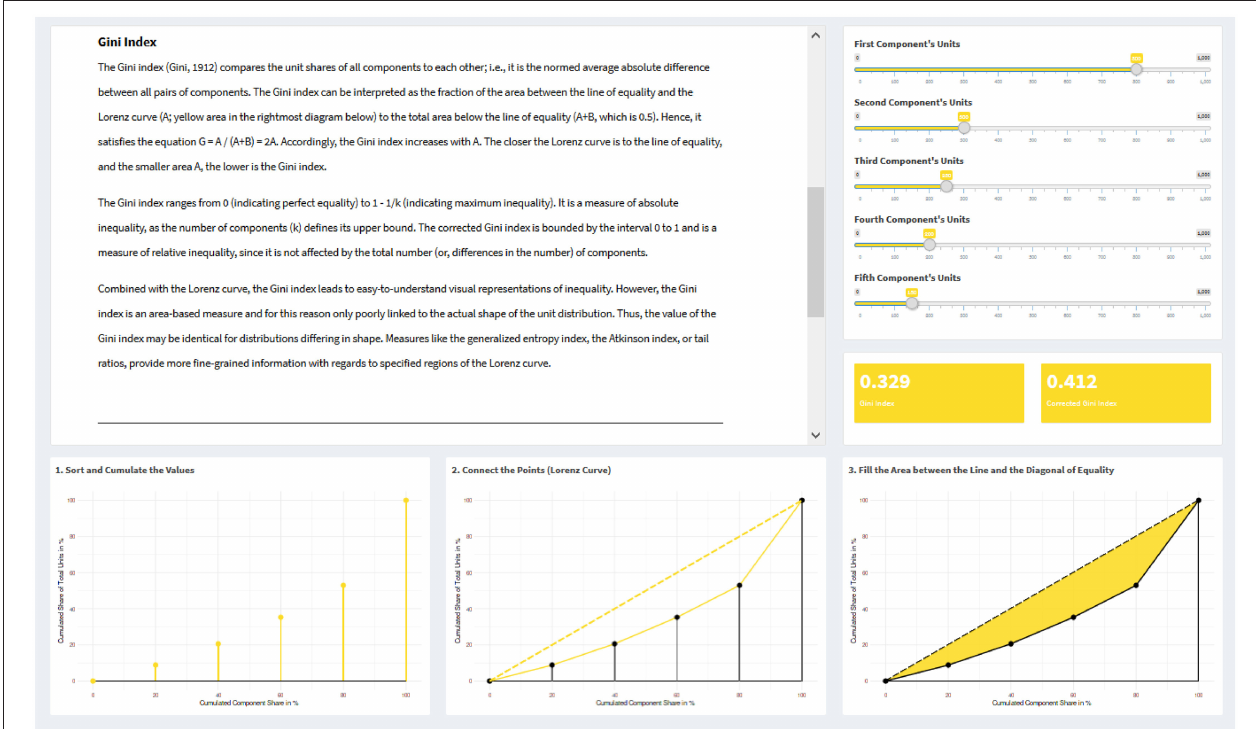
FIGURE 1 | Example visualizations of the Lorenz curve and the Gini index from the interactive web application. On the upper left side, a text vignette explains the Gini index; on the upper right side, a slider panel with five sliders allows to create a distribution with five components; below this, a panel displays the value of the Gini index for the created distribution. At the bottom, three plots are created (based on the specific slider inputs), showing how a Lorenz curve is constructed and influenced by the data input, along with the area that corresponds to the Gini